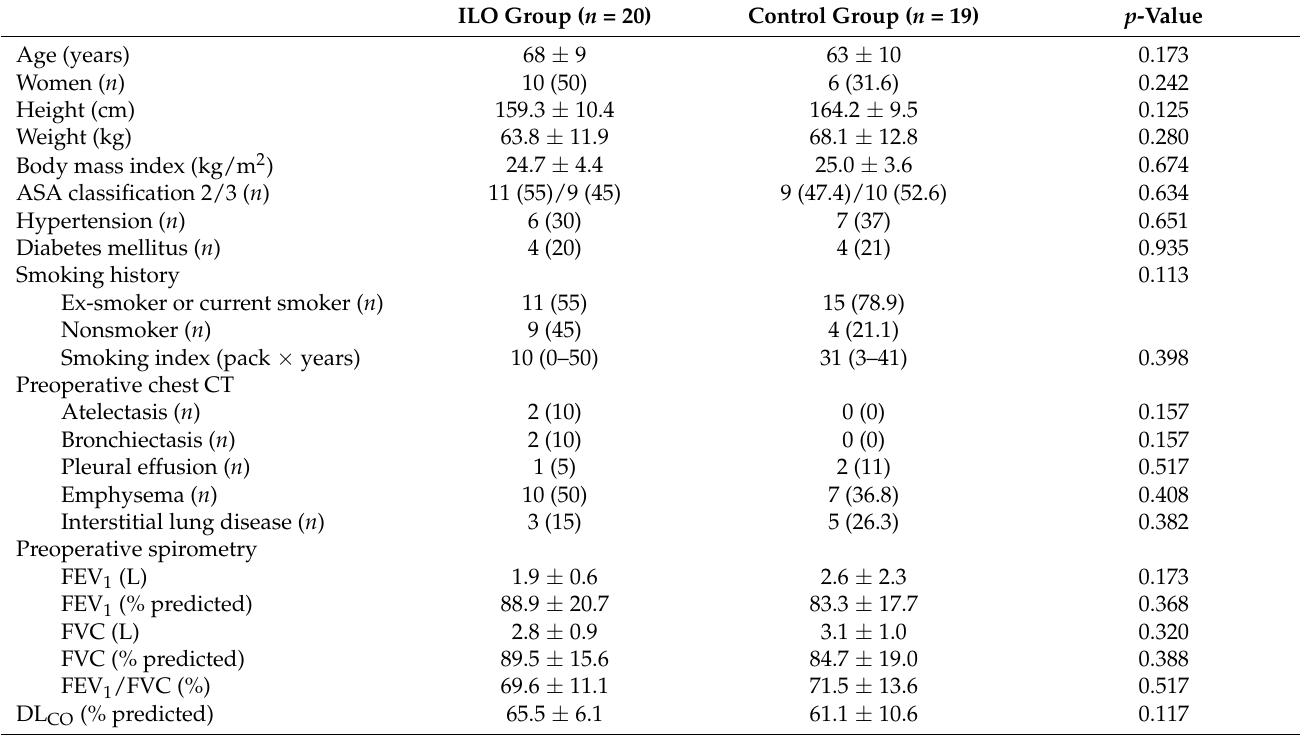
Table 1. Preoperative data.